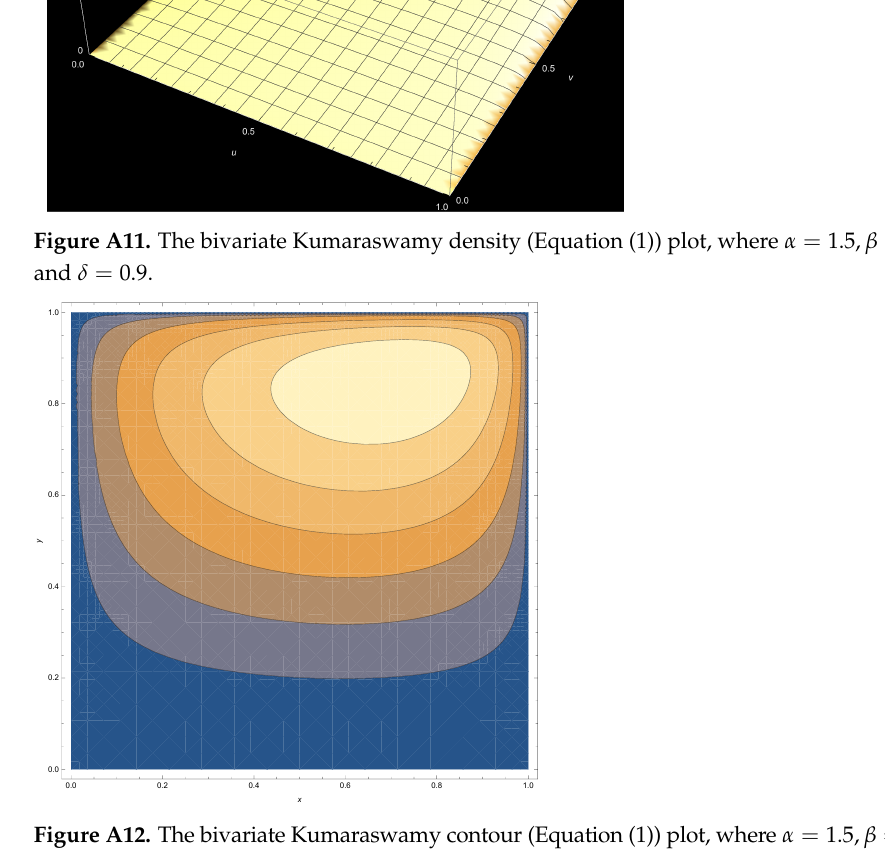
Figure A12. The bivariate Kumaraswamy contour (Equation (1)) plot, where α = 1.5, β = 2.5, θ = 0.5 and δ =